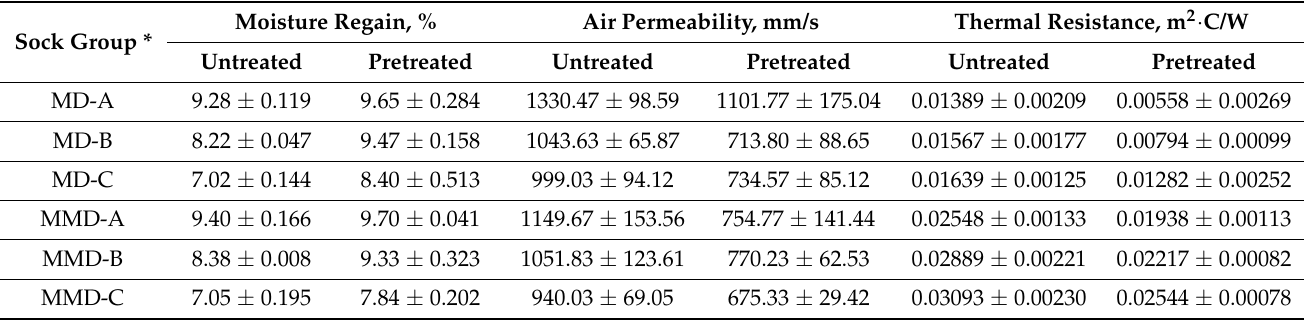
Table 9. Mean values of the comfort properties calculated for groups A, B and C of the untreated and pretreated socks made from differently spun modal and micro modal